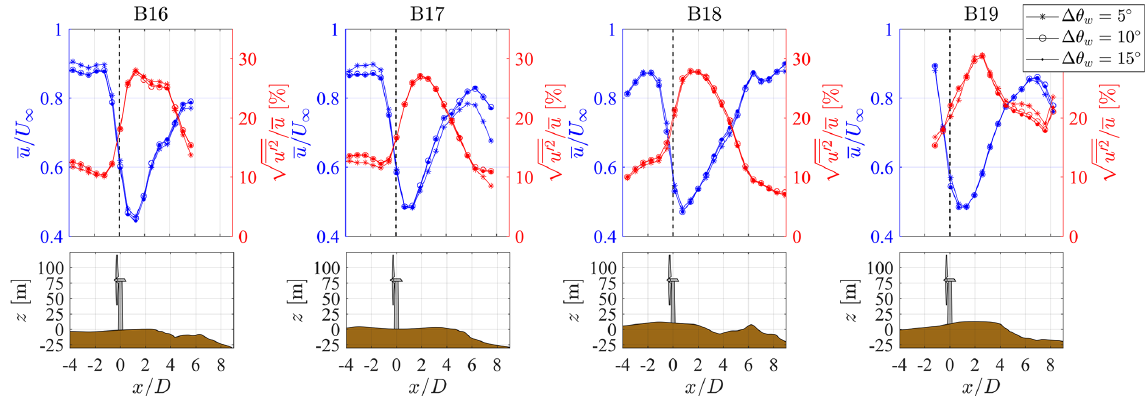
Figure 12. Rotor-averaged streamwise mean velocity and turbulence intensity as a function of the downstream distance from the turbine and associated altitude profile.